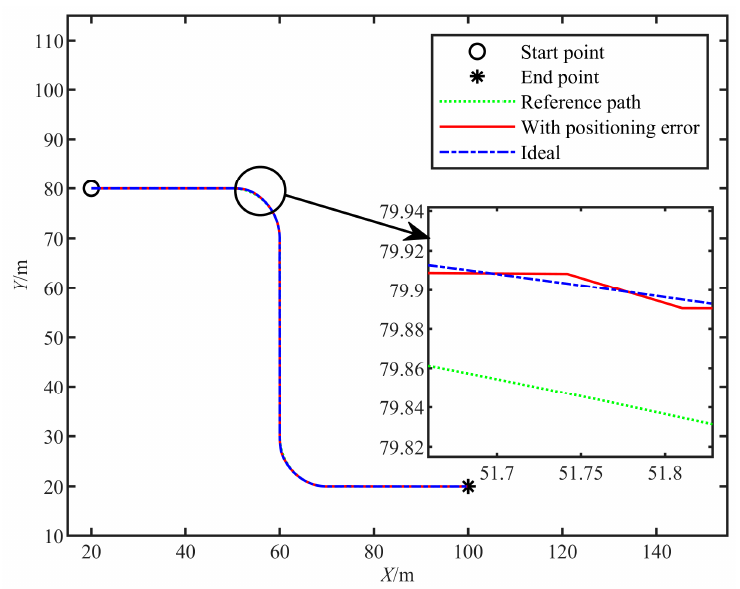
Figure 18. The trajectory of the simulation with positioning errors.